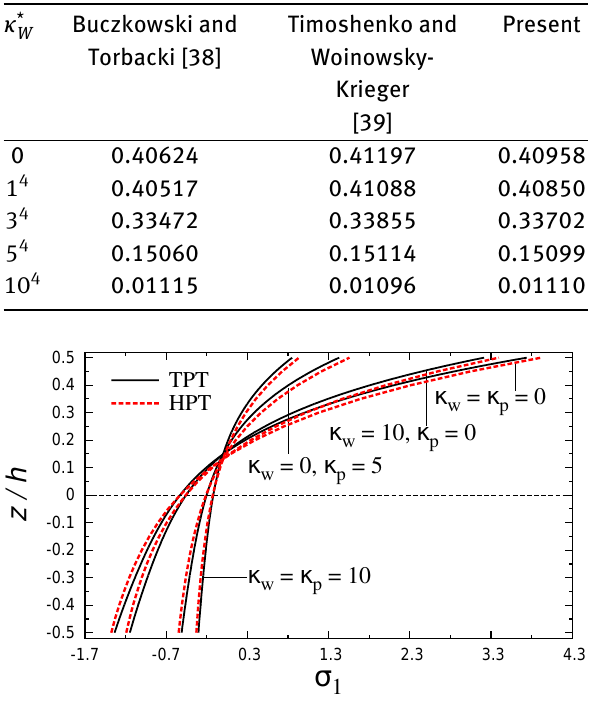
Table 3: Comparison of the deflection 10 2 Dw (0.5 a , 0.5 b , 0)/( q 0 a 4 ) of the isotropic square plate on Winkler parameter under uniformly distributed load ( κ * = 0, h = 0.05 a ) . P